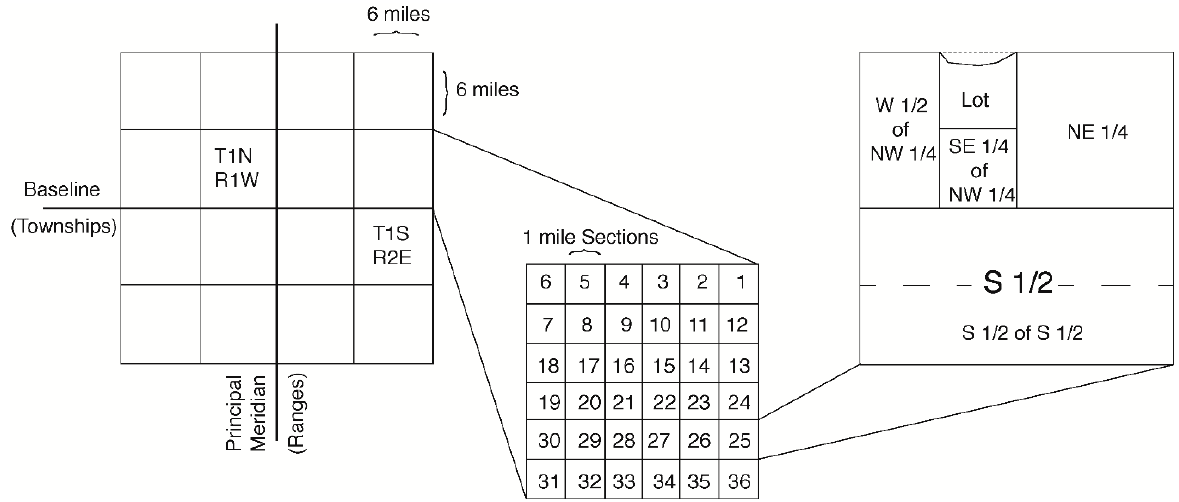
Figure 2. Public Land Survey System (PLSS) structure and aliquot